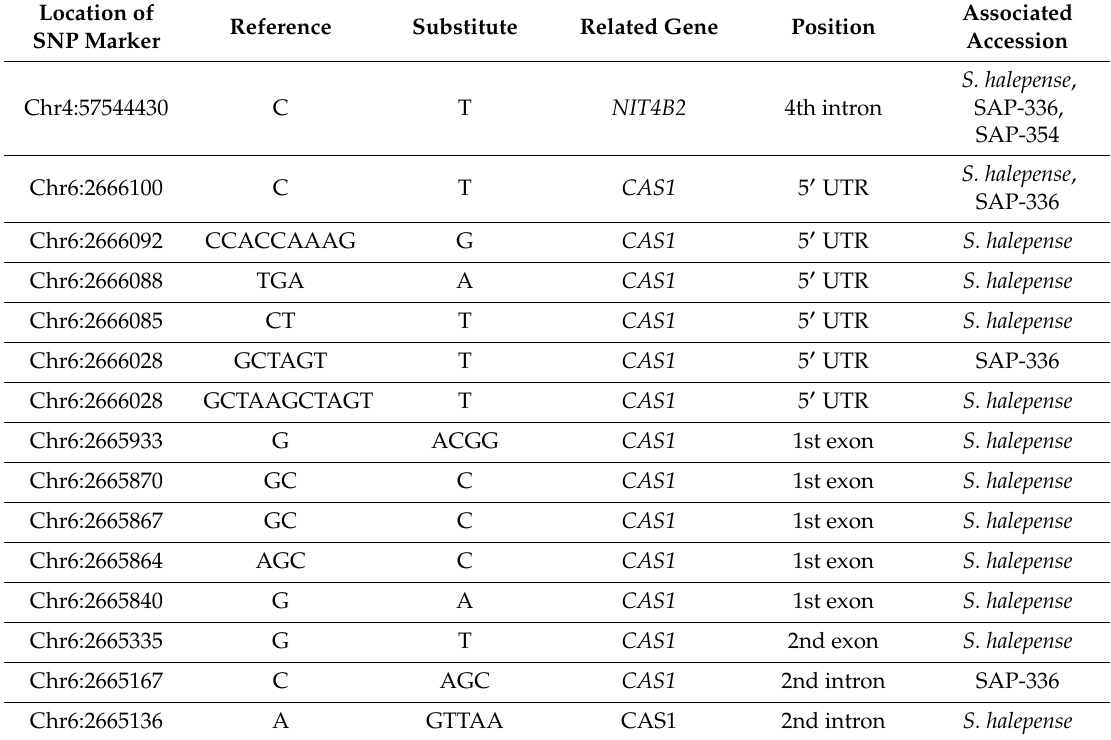
Table 2. Significant single nucleotide polymorphisms (SNPs) related to dhurrin metabolism by representative sorghum